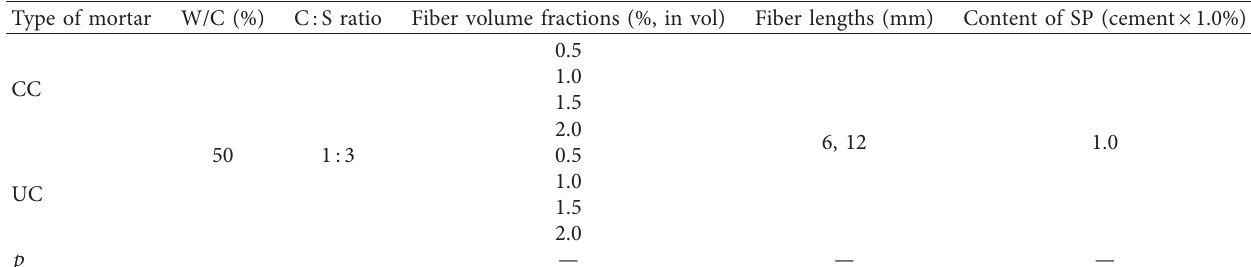
Table 4: Mix proportions of mortar.